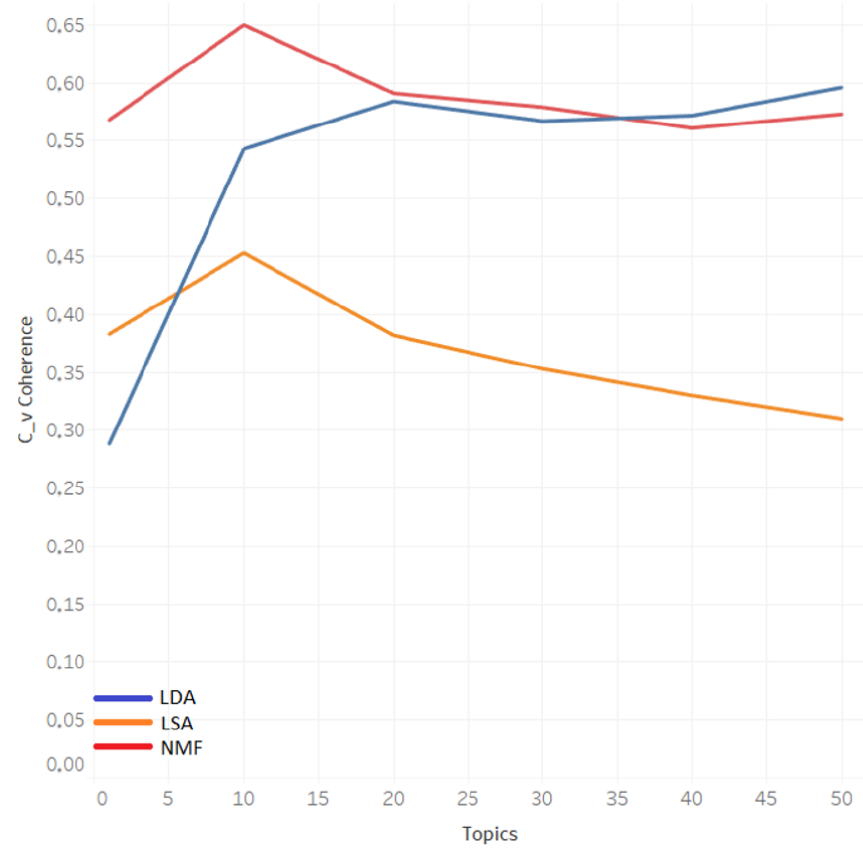
Figure 6. C_v coherence of LDA, LSA, and NMF with a k of 1 through